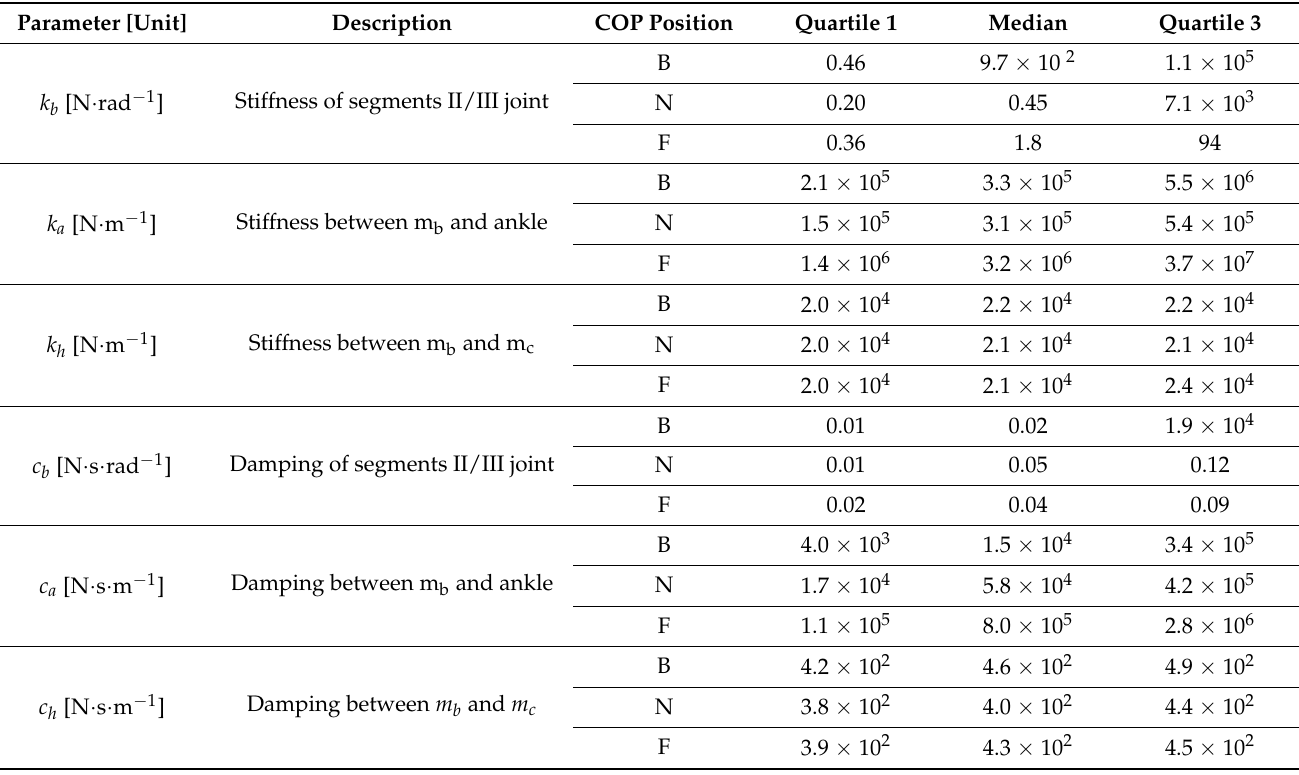
Figure 6. Box plot analysis of: ( a ) the damping for the rearfoot sole ( c e ), ( b ) midfoot sole ( c f ), ( c ) forefoot sole ( c g ) and ( d ) the plantar aponeurosis ( c d ) when the COP was in the backward (B), natural (N) and forward (F) positions. Table 2. Median, 25th and 75th quartiles for the stiffness and damping at three locations ( k b , k a , k h , c b , c a and c h ) when the COP was in the backward (B), natural (N) and forward (F)